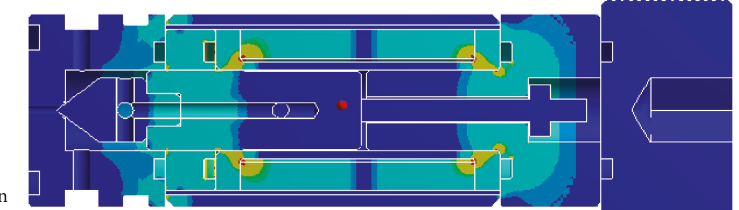
Figure 10: Total heat flow distribution after heat insulation.